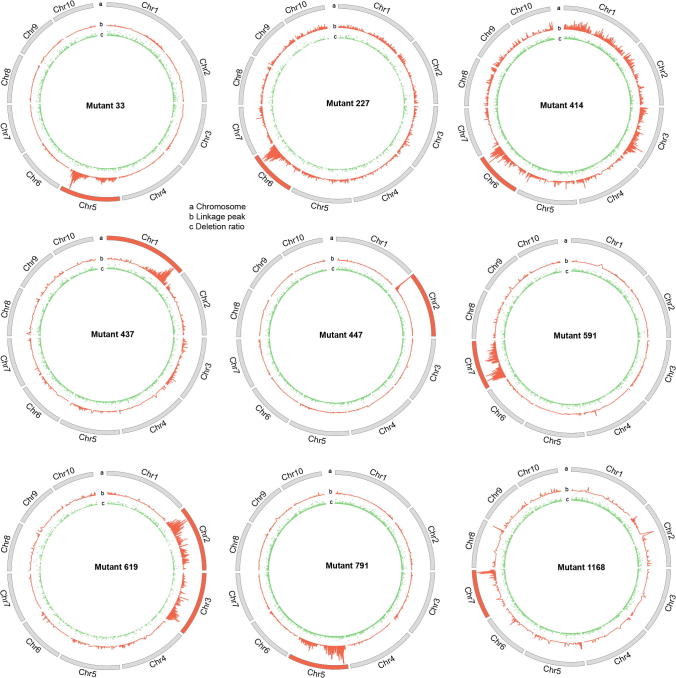
Linkage peaks and deletion identification in nine opaque and small kernel mutants Linkage peaks and deletion identification are shown in mutants 33 (red layer, linkage peak ranging from 0 to 65; green layer, deletion ratio based on Dnn/(Dnm+0.05) in a comparison of normal and mutant F2 samples ranging from 0 to 184), 227 (red layer, linkage peak ranging from 0 to 80; green layer, deletion ration ranging from 0 to 168), 414 (red layer, linkage peak ranging from 0 to 47; green layer, deletion ration ranging from 0 to 284), 437 (red layer, linkage peak ranging from 0 to 29; green layer, deletion ration ranging from 0 to 192), 447 (red layer, linkage peak ranging from 0 to 79; green layer, deletion ration ranging from 0 to 272), 591 (red layer, linkage peak ranging from 0 to 46; green layer, deletion ration ranging from 0 to 188), 619 (red layer, linkage peak ranging from 0 to 30; green layer, deletion ration ranging from 0 to 163), and 791 (red layer, linkage peak ranging from 0 to 64; green layer, deletion ration ranging from 0 to 386). The circle layers are the same to those in Figure S4.